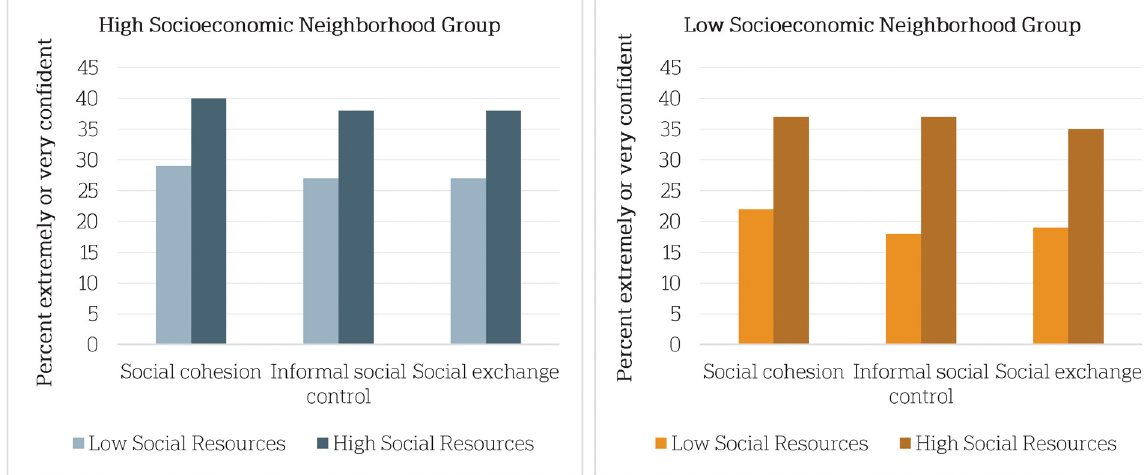
Fig 2. Social resources and resilience by neighborhood SES. The 12 neighborhoods in the survey are divided into high and low SES based on median household income (six neighborhoods each either above or below $73,601 a year). Social cohesion, informal social control and social exchange are all measured for each individual respondent with a factor score derived from their answers to a series of related questions. These factor scores are then split at the median (high and low, as